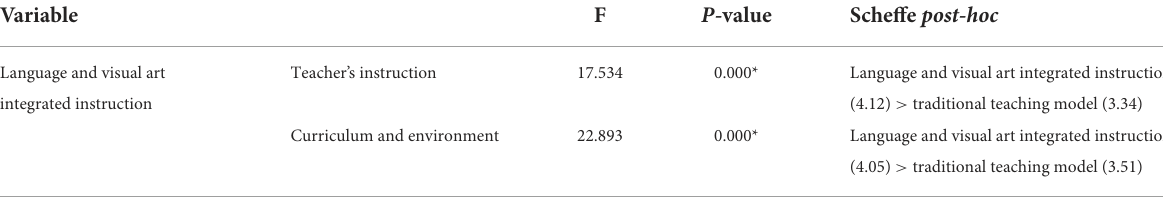
TABLE 1 Variance analysis of language and visual art integrated instruction in language satisfaction.